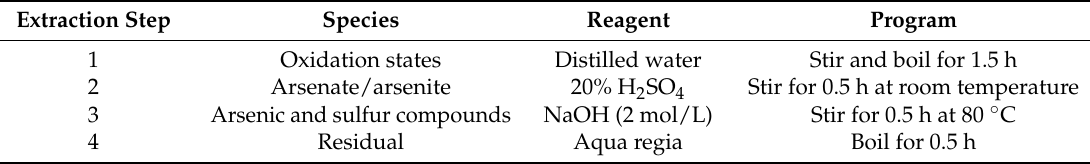
Table 1. The separation process of the arsenic phase of the raw ASS.